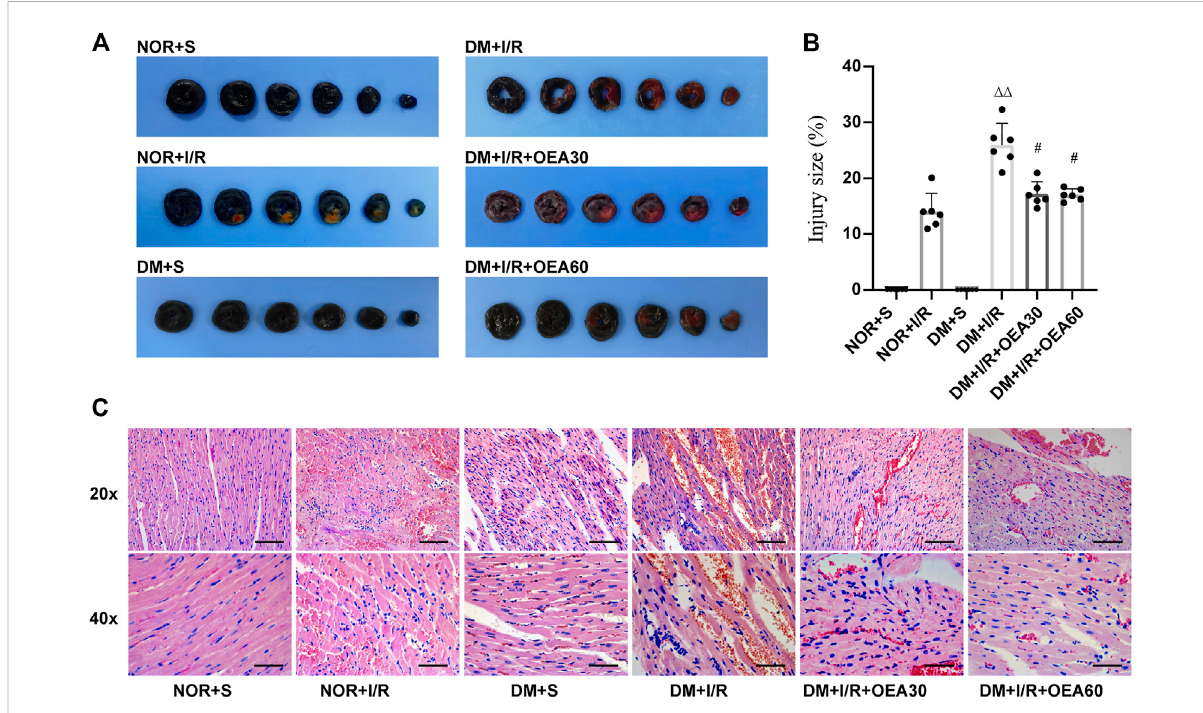
OEA attenuated myocardial tissue injury in diabetic myocardial ischemia-reperfusion rats. (A,B) Evans blue-TTC staining of myocardium, in whichbluerepresentstheregionofhealthymyocardialtissue,andredrepresentstheregionofischemia-reperfusioninjury( n =6); (C) HEstainingof myocardial tissue, including hematoxylin (blue) staining of nucleus, and eosin (red) staining of cytoplasm, 20x scale = 100 μ m, 40x scale = 50 μ m. Data were expressed as mean ± SEM, ΔΔ P < 0.01 vs. NOR + I/R group; # p < 0.05 vs. DM + I/R